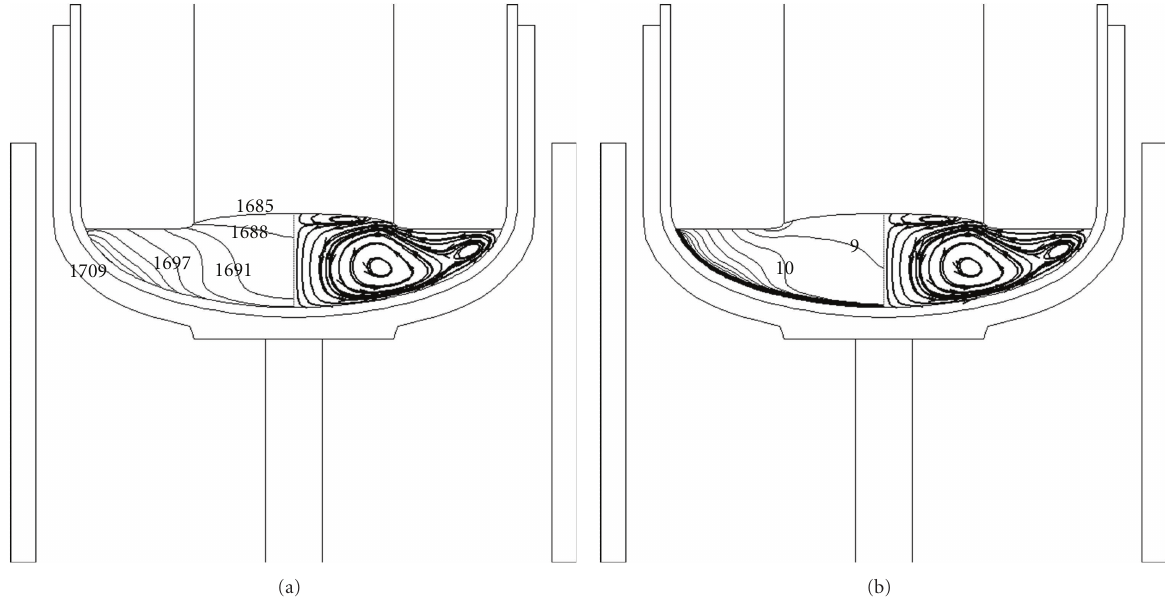
Figure 7: Distribution of temperature, streamtrace, and oxygen concentration in the melt for L = 700 mm in a conventional CZ furnace ( h = 0mm): (a) isothermal lines (left) and streamtraces (right); (b) oxygen concentration isolines (left) and streamtraces (right). The units of temperature, velocity vector, and oxygen concentration are K, m/s, and ppma, respectively. The spacing of the isothermal lines and concentration isolines are 3 K and 1ppma, respectively.